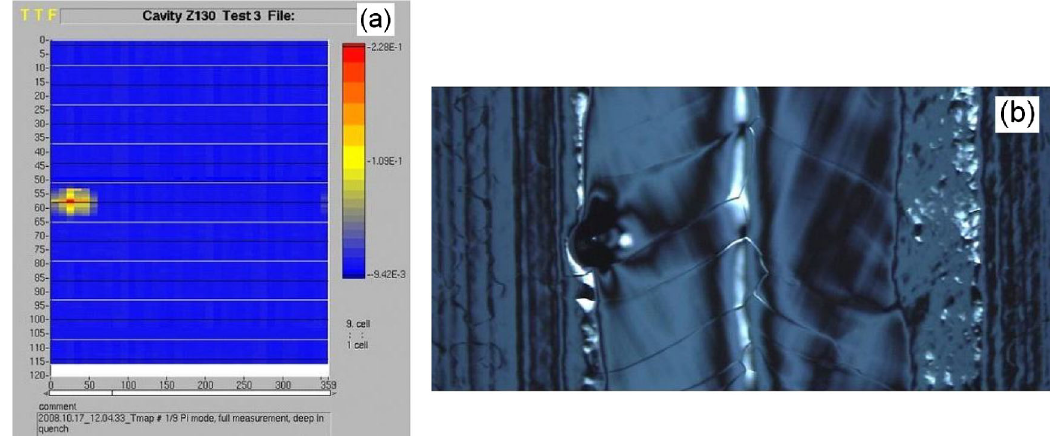
8(a).FIG. FIG. 9. (a) Light microscope image of the hot spot represented in Fig. 8(a); (b) 3D microscope image of the hot spot represented in Fig. FIG. 10. (a) T-map of cavity Z111; (b) high resolution camera inspection of the hot spot of